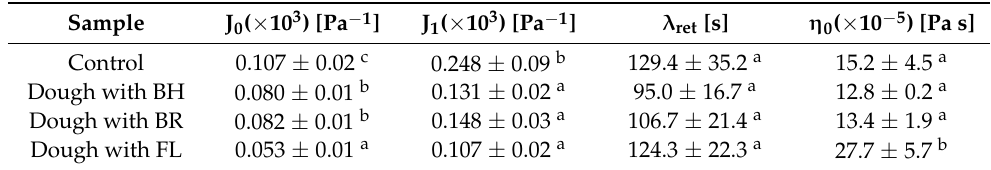
Table 5. Parameters of Burger’s model of dough samples.